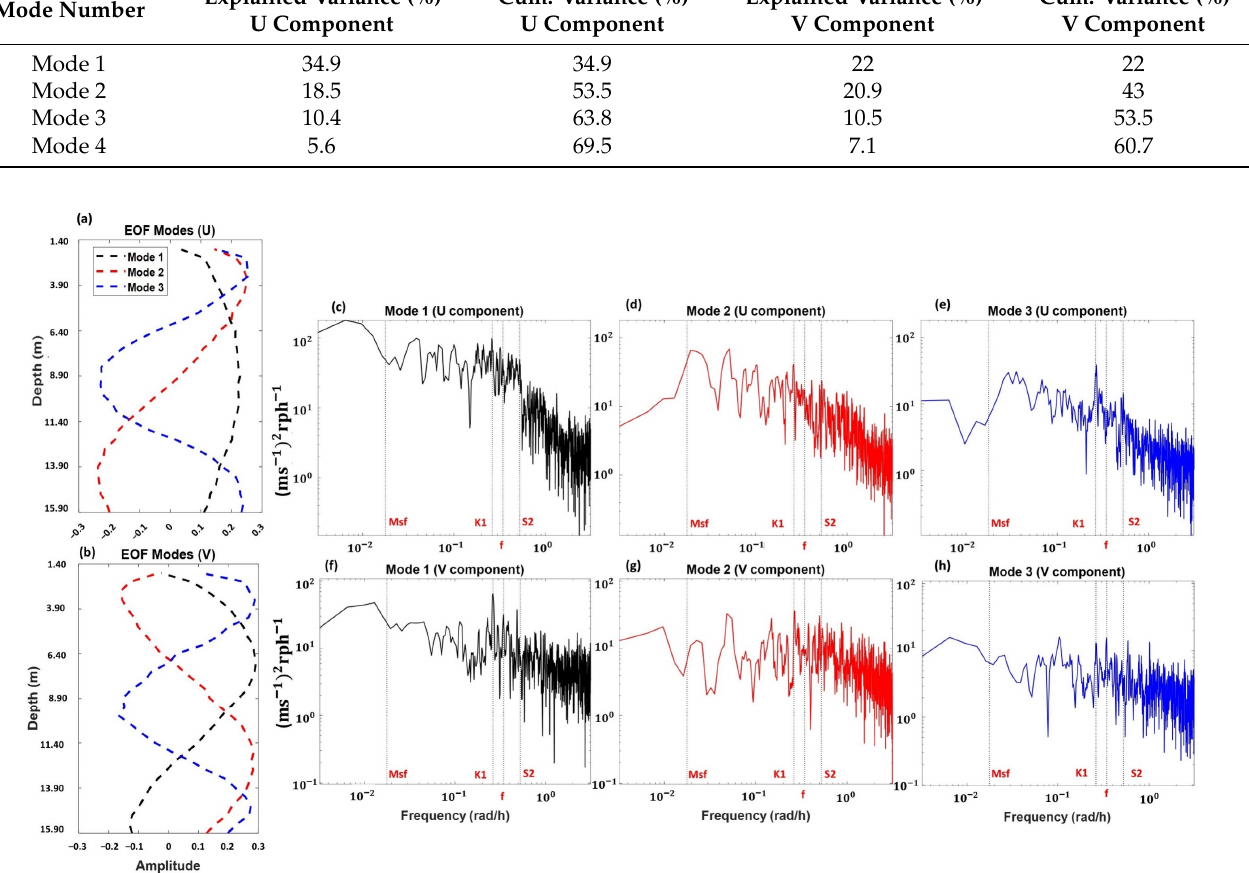
Figure 7. Spatial pattern for the first 3 EOF modes for the zonal ( a ) and meridional ( b ) components measured by the ADCP probe. Frequency spectra ( c – h ) of the principal component associated with the 3 modes. Table 7. The fraction of variance retained by the first 4 EOF modes and the cumulative variance.